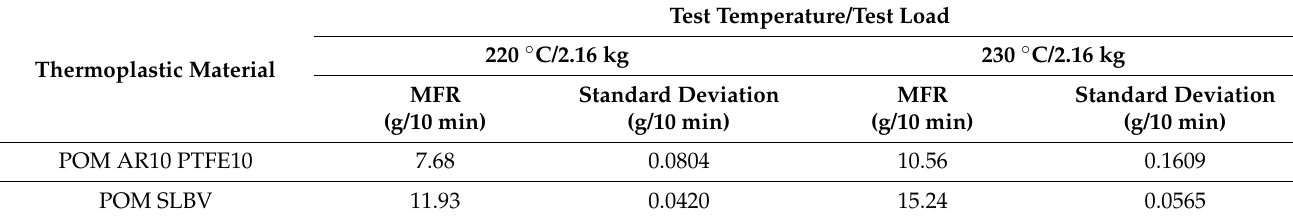
Table 2. MFR at different test